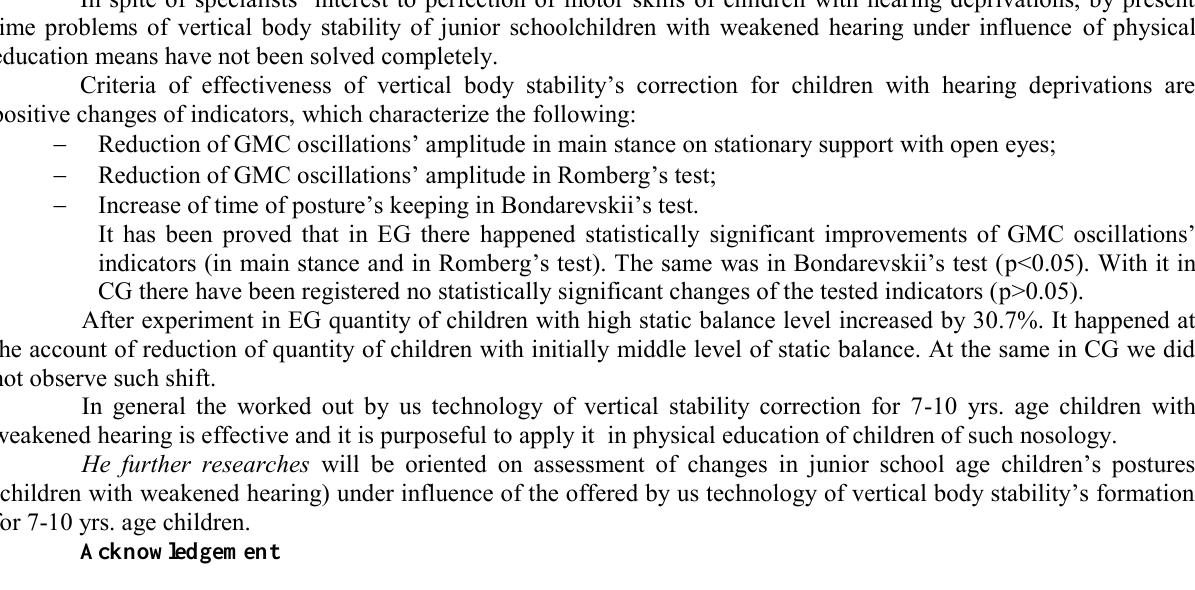
Fig. 1. Distribution of the tested by level of static balance before and after experiment (n=26), % -high; - sufficient; -middle; - initial